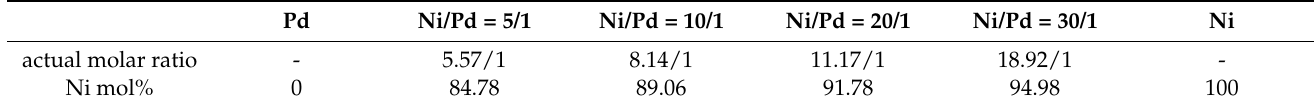
Table 1. Actual metal contents in the hydrogel and particle average